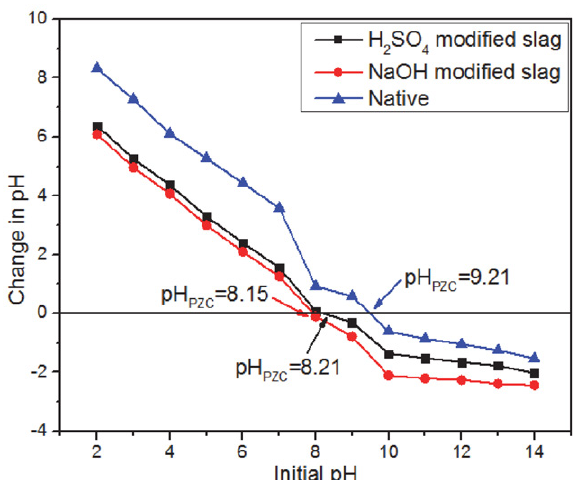
Figure 1. Point of zero charge (pH PZC ) of the synthesised adsor- bents Table 1. Physical properties of the native and chemically modified brick kiln slag (BKS)